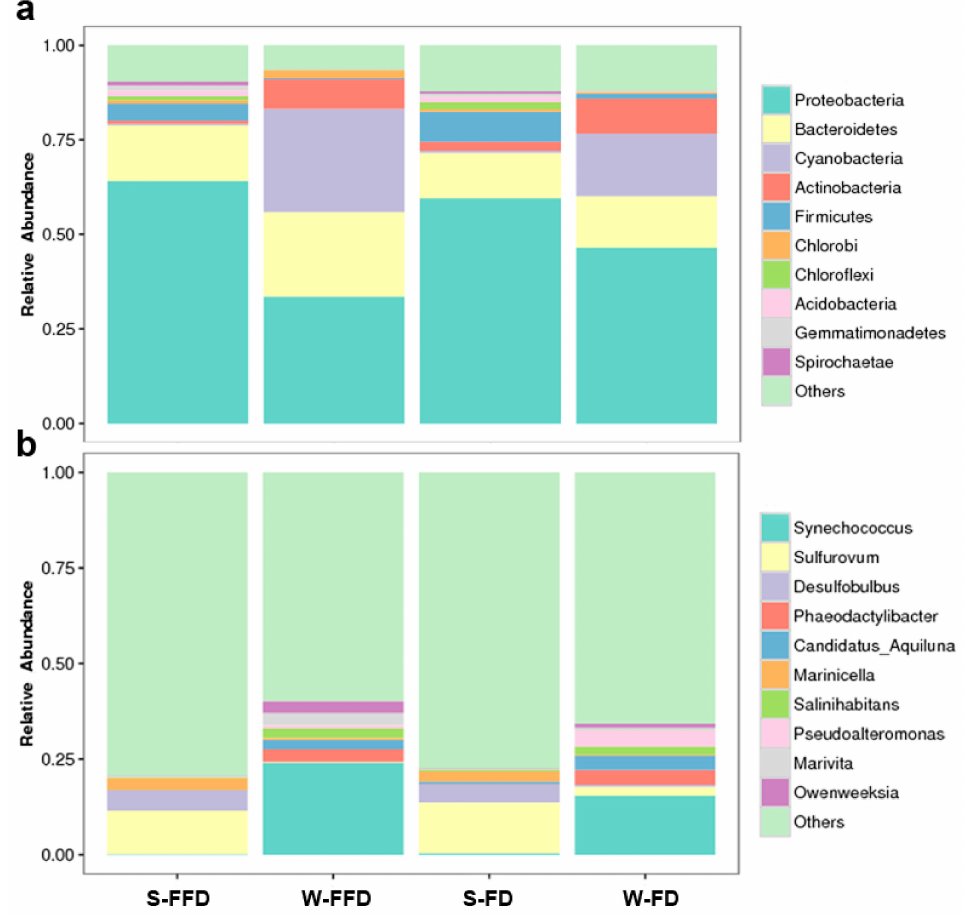
Figure 3. The top 10 taxa at both ( a ) phylum and ( b ) genus level in all